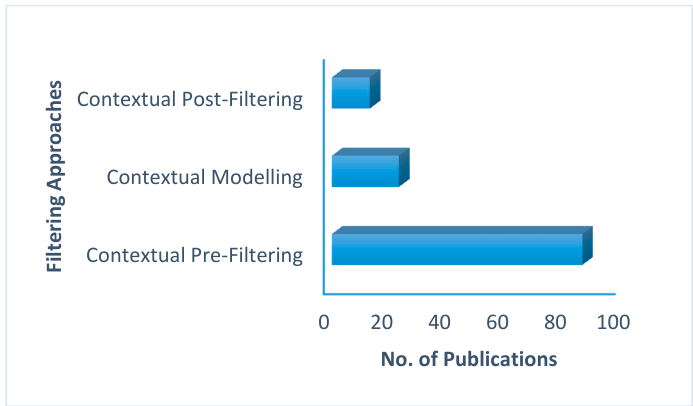
Figure 6. Classification by filtering approach.